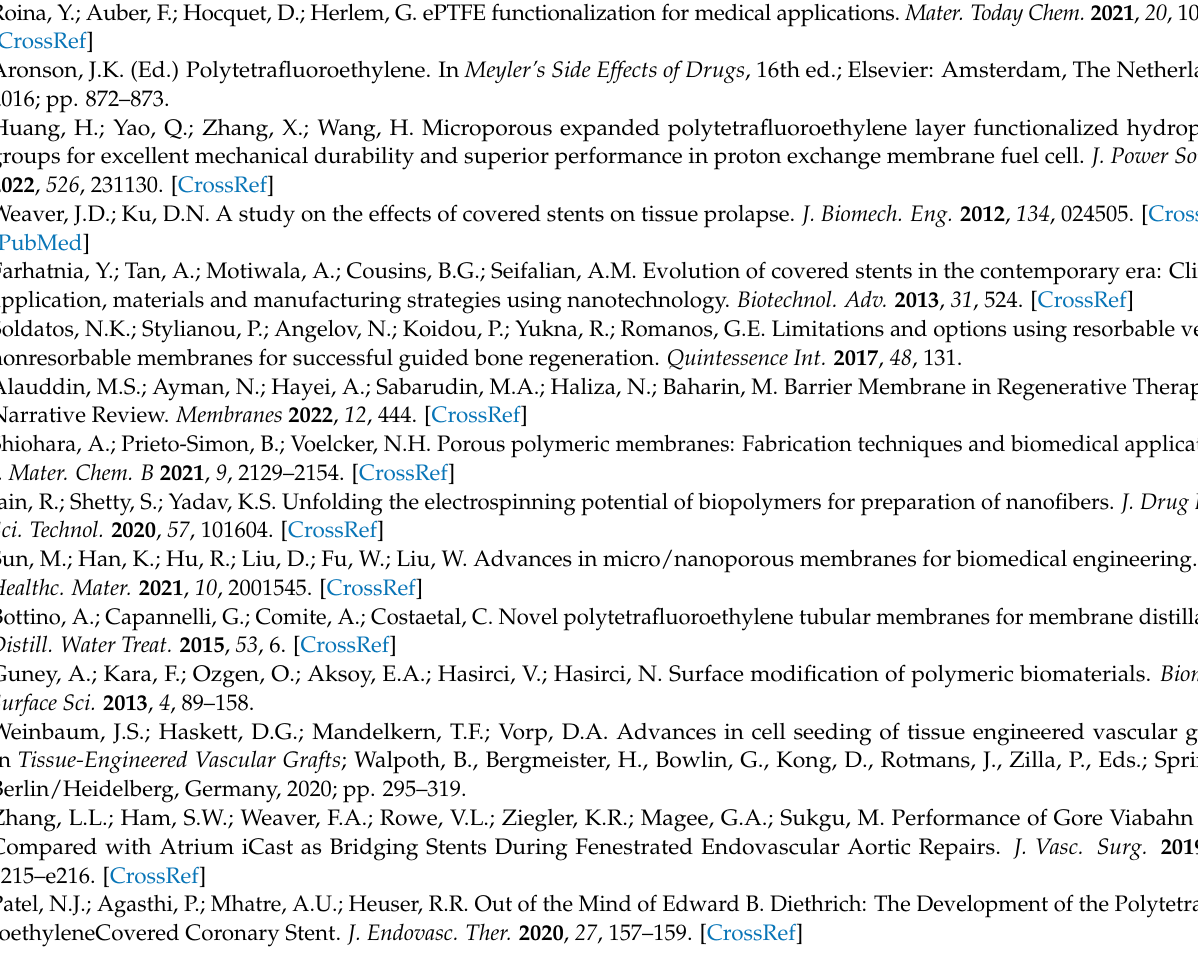
Figure A3. Multiple stenosi observed with angiography ( A ) and follow up post-operative ( B ).